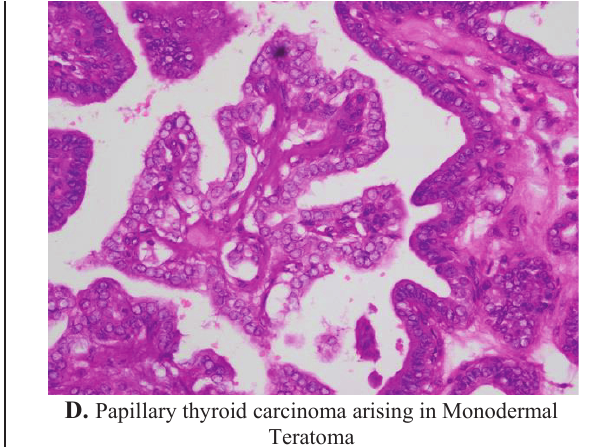
Fig-1: Different Morphological Spectrum in